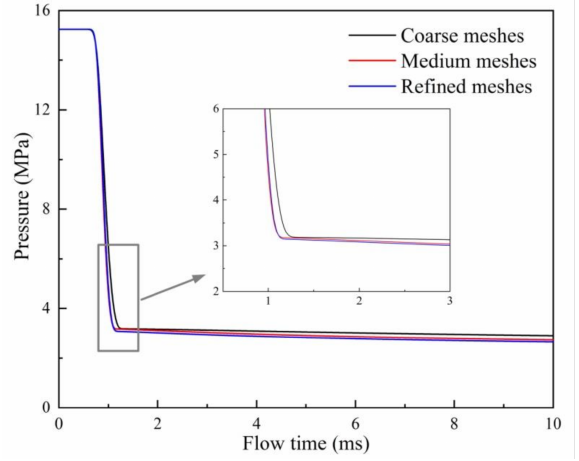
Figure 2. Pressure changes obtained using different mesh